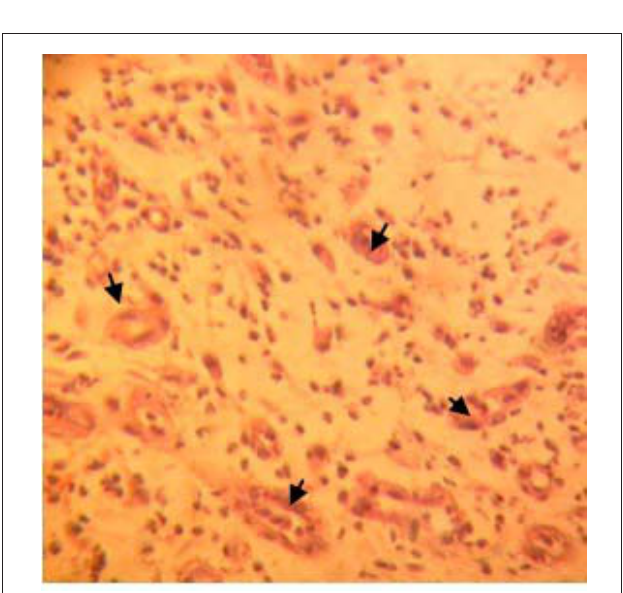
Fig. 1. Granulation tissue formation in Group A. Arrows point to edema and granulation tissue formation. Inflammation and edema are evident. (X 400- H & E staining)